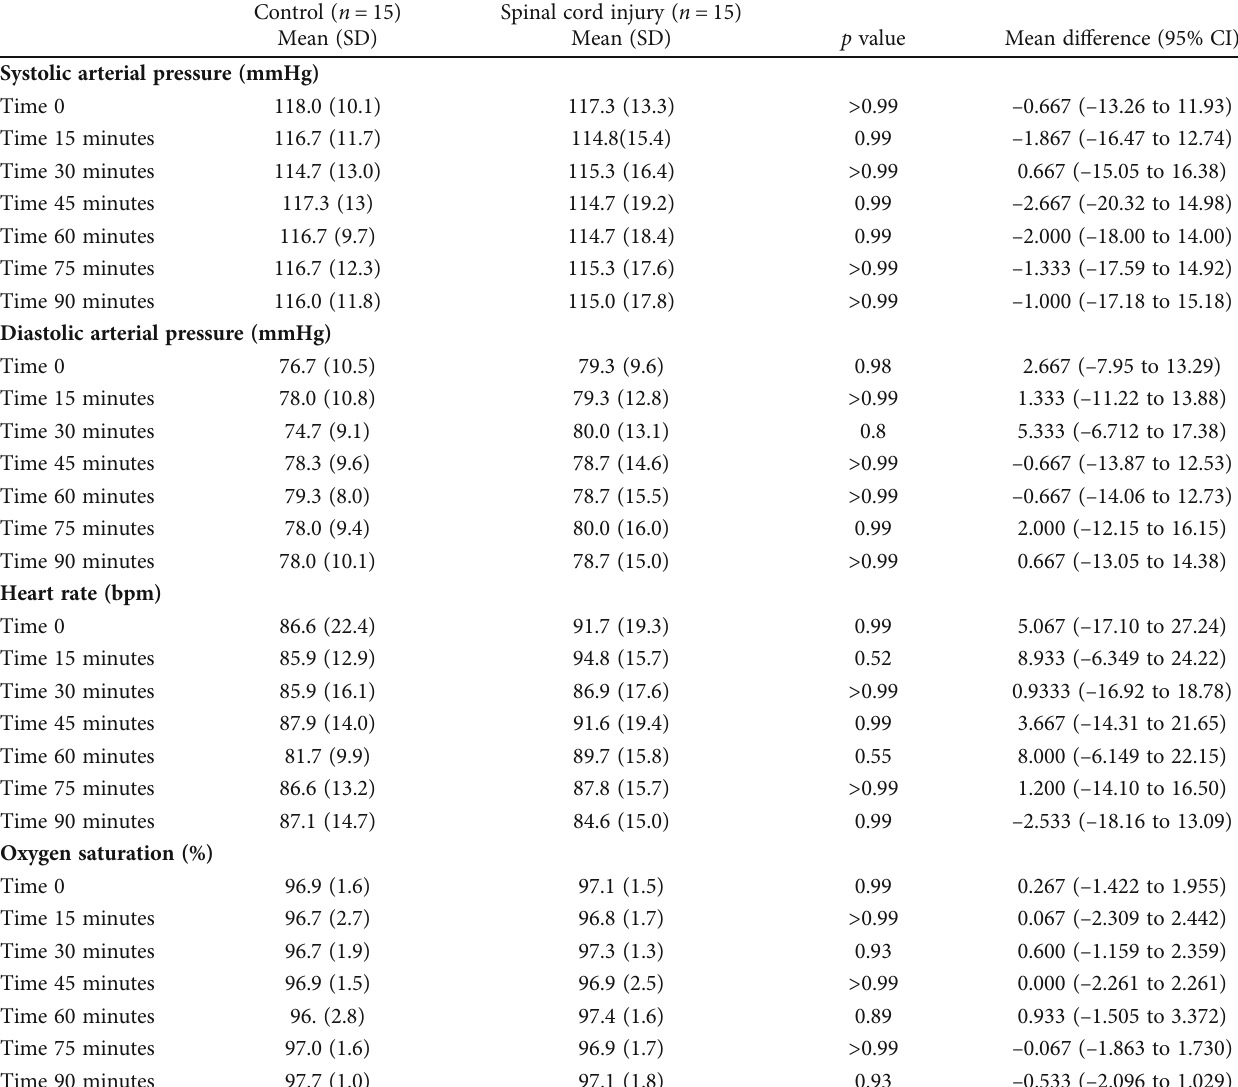
Table 2: Comparison of cardiovascular parameters over 90 min of maintaining the orthostatic